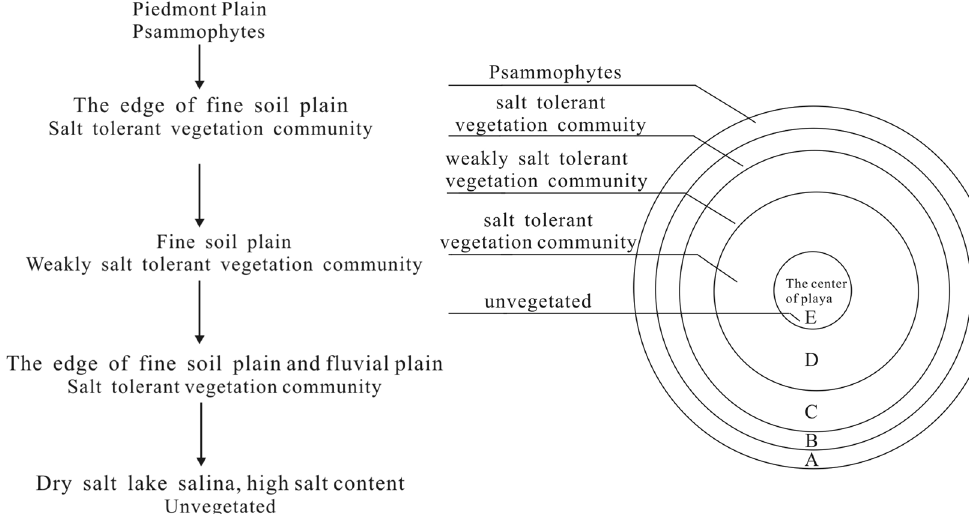
Figure 6. The vegetation is zoned distributed with the saline lake or playa at the